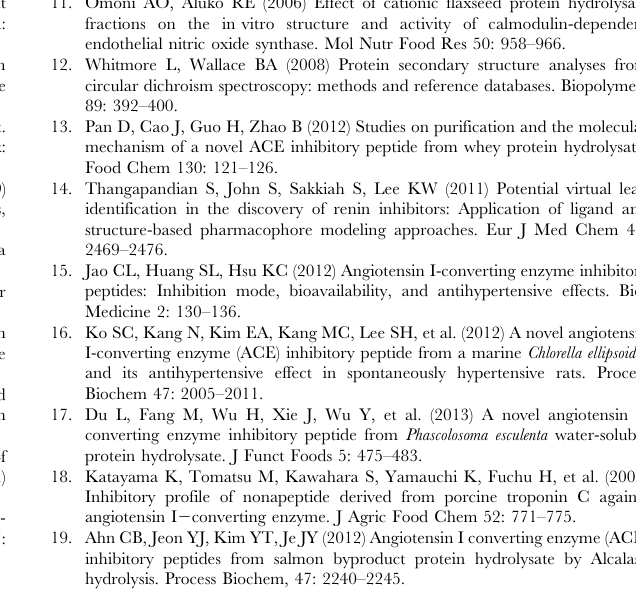
Table S1 Predicted binding energies (Electrostatic energy: Eele; Van der Waals energy: Evdw; Potential energy: Epot, kJ/mol). Table S2 Hydrogen bonds observed between ACE (PDB: 1O86) or renin (PDB: 2V0Z) and the docked top ranked pose of peptides. Table S3 The distance between Zn 2 + coordination amino acid residues within ACE (PDB: 1O86) and bioactive